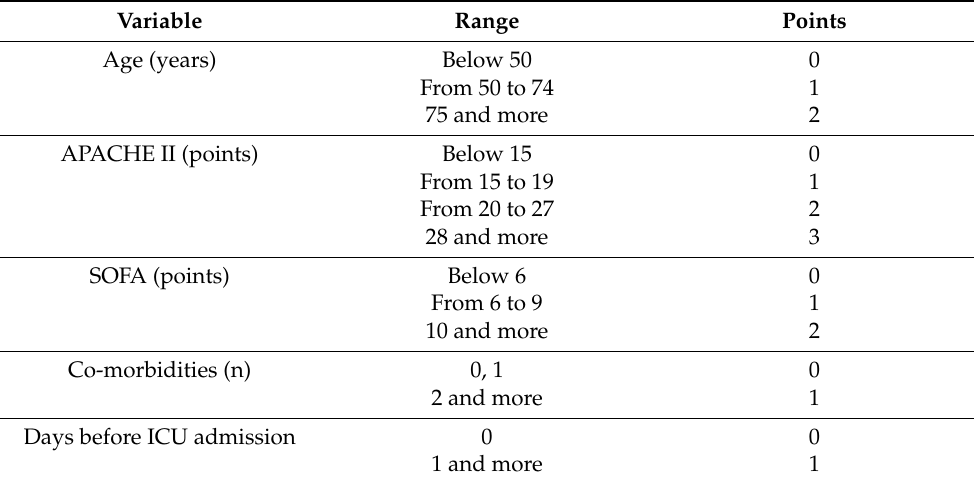
Table 1. Variables used to calculate the mNUTRIC score. The score on the mNUTRIC scale ranges from 0 to 10